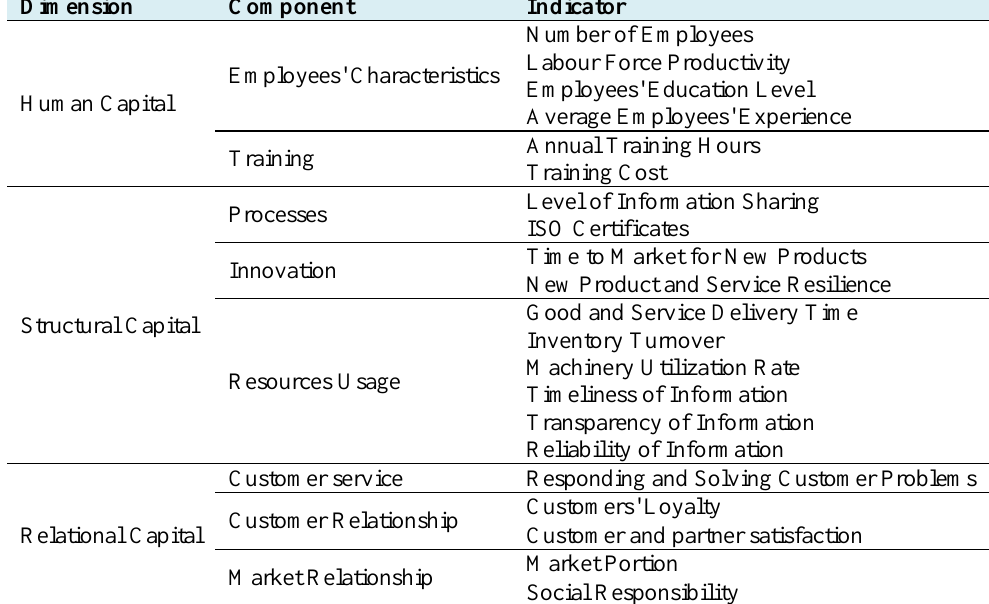
Table 8. The final model for measuring intellectual capital in